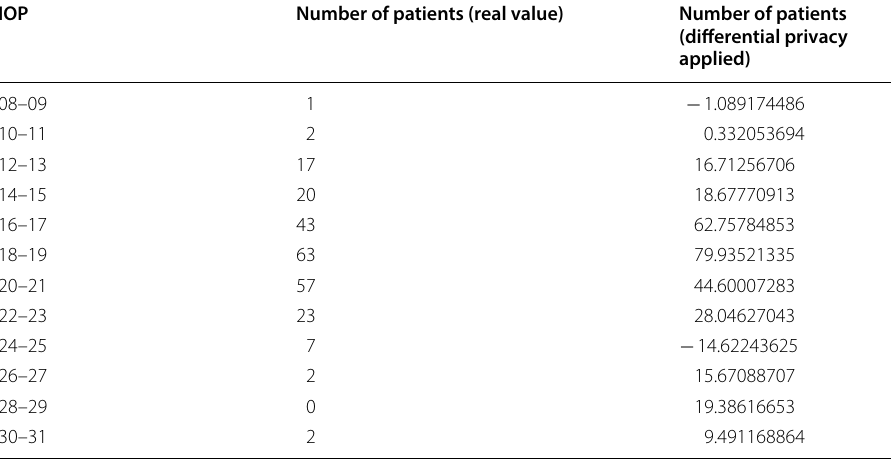
Table 2 Intraocular pressure ranges ranges based on the Woolson dataset (Woolson) with the differential privacy applied at ε 0.1 [17] = IOP Number of patients (real value) Number of patients (differential